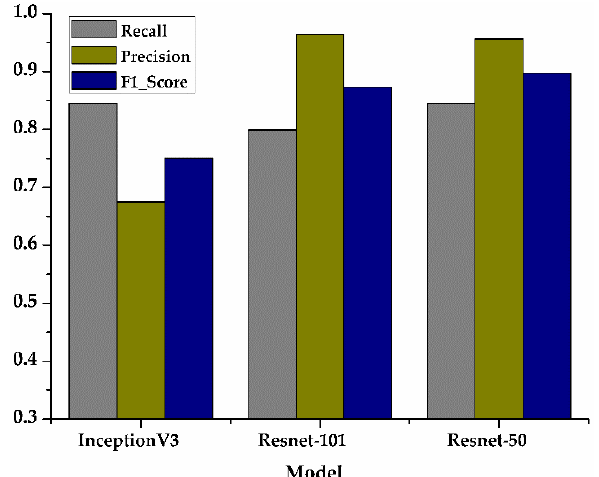
Figure 6. Comparison results of Recall, Precision, F1_score for three models. Table 3. Comparison of Confidence Intervals (CI) and Average Accuracy for different models.